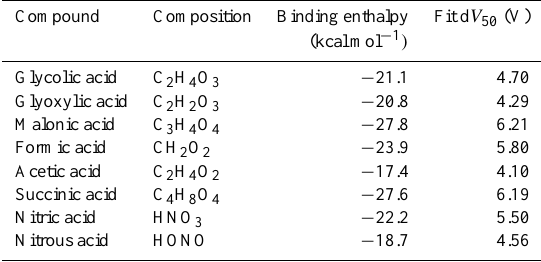
Table 1. Compounds used to determine the relationship between d V 50% and binding enthalpy derived from quantum calculations (Iyer et al., 2016) at the DLPNO-CCSD(T)//PBE-aug-cc-pVTZ-PP level. The relationship is approximately linear R 2 = 0 . 9 (see Fig. 4). For details see